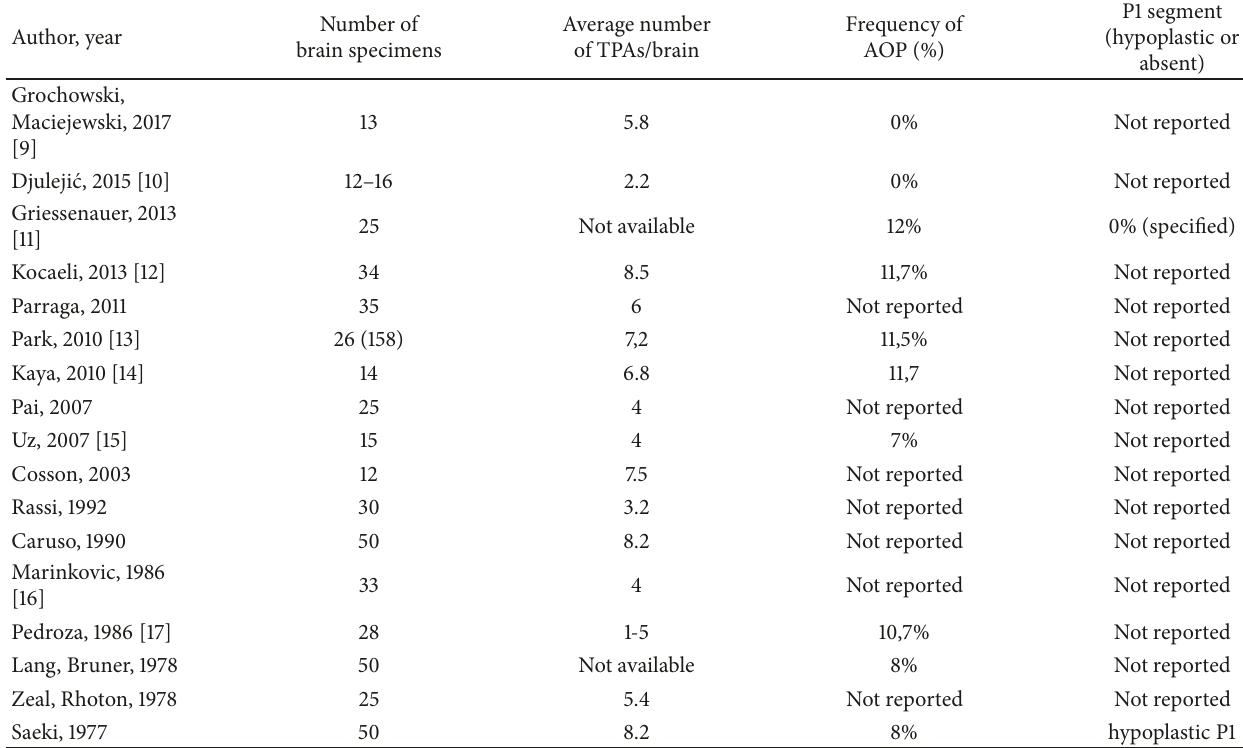
Table 1: Summary of microvascular anatomic investigations of the posterior vascularization and reported incidence of AOP associated or not with other variants in the circle of